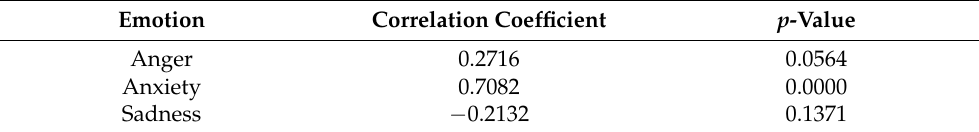
Table 5. The correlation coefficient between the emotion index and preventive behavior